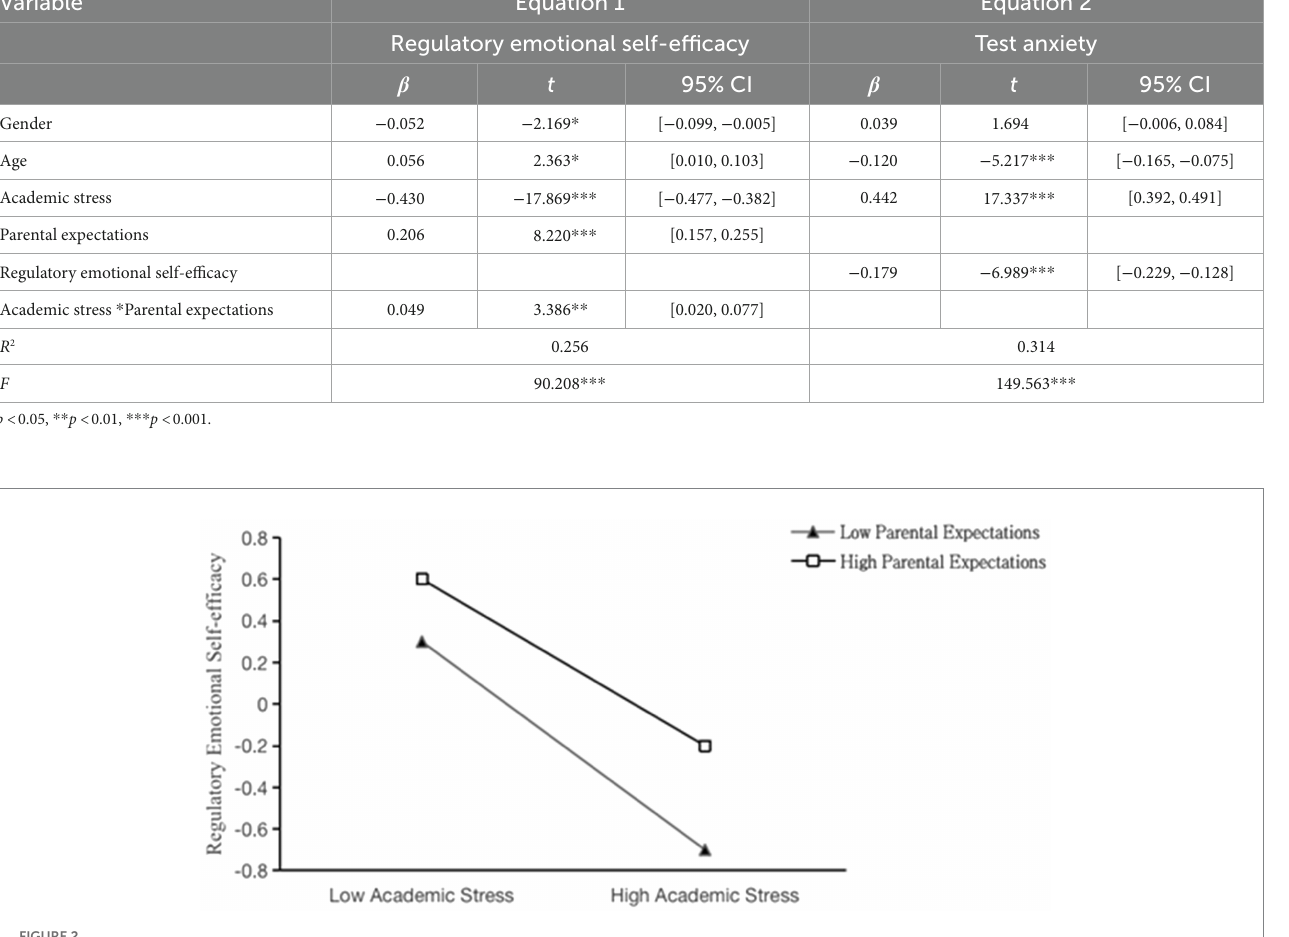
FIGURE 2 The mediating role of parental expectations in academic stress and regulatory emotional